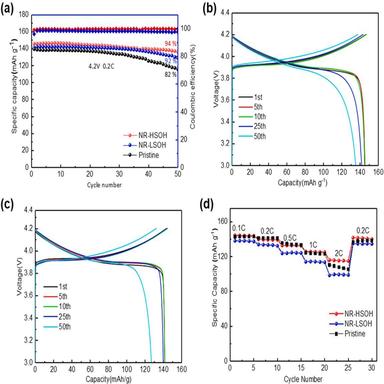
Electrochemical performance of the NR-HSOH and the NR-LSOH samples. (a) Capacity retentions and the corresponding coulombic efficiencies of the pristine, the NR-HSOH, and the NR-LSOH samples after 50 cycles at 2.7–4.2 V. (b) Charge/discharge voltage profiles of the NR-HSOH sample. (c) Charge/discharge voltage profiles of the NR-LSOH sample. (d) Rate performance of the pristine, the NR-HSOH and the NR-LSOH samples.